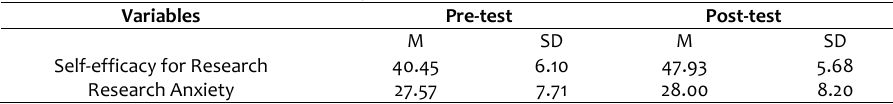
Table 3. Pre-test and Post-test Mean Scores for